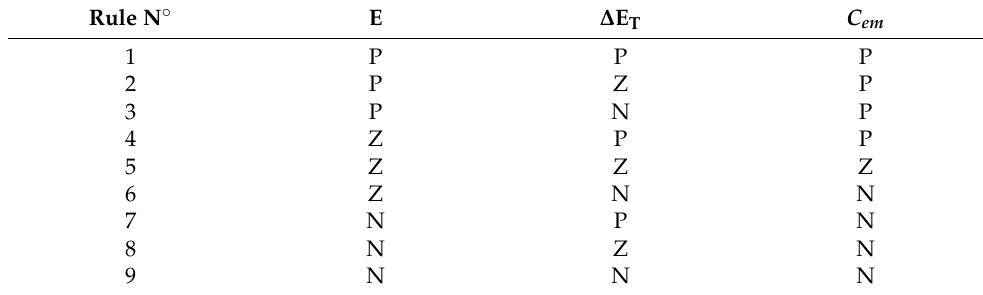
Table 3. Speed control inference